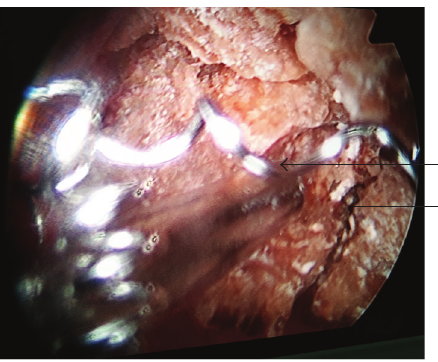
Figure 3: Intraoperative picture showing the renal pelvic stone (straight line) with the migrated stainless steel embolization coil (arrow) as nidus in the pelvicalyceal system.